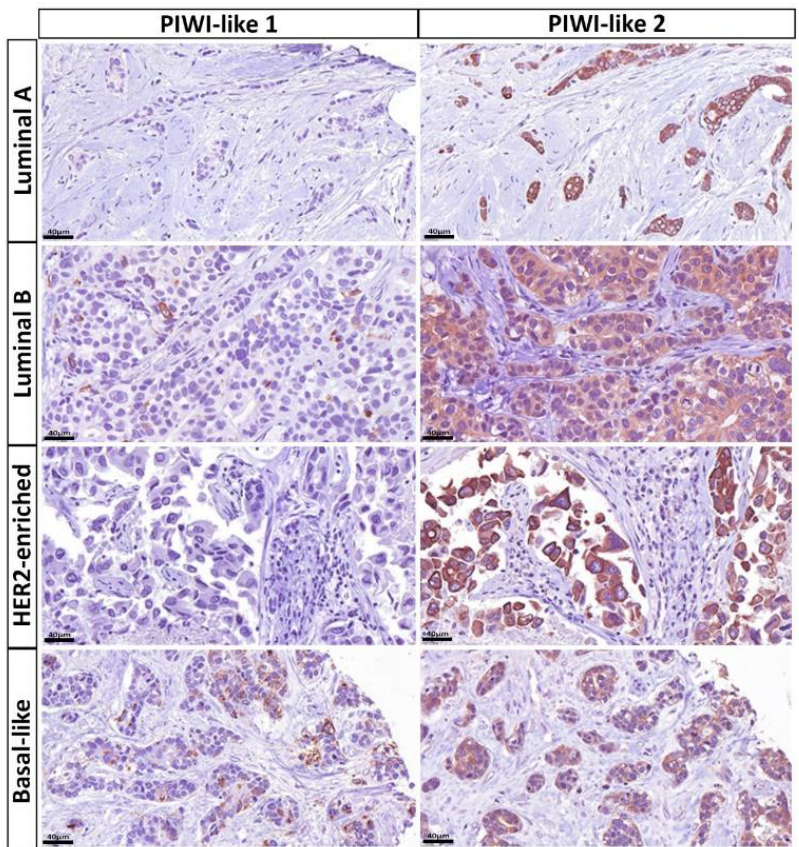
Figure 8. Immunohistochemical (IHC) expression patterns of PIWI-like 1 and PIWI-like 2 varied within the molecular PAM50 breast cancer subtypes: Luminal A breast cancer showed strong and homogenous PIWI-like 2 expression (IRS 12/12) in most cases, whereas there was no detection of PIWI-like 1 expression (IRS 0/12). In contrast, Luminal B and HER2-enriched tumors presented with either no or slight PIWI-like 1 expression (IRS 2/12 and 0/12, respectively). However, PIWI-like 2 staining was typically moderate to high (IRS 8/12 and 9/12, respectively). Basal-like breast cancer depicted increased PIWI-like 1 (IRS 4/12), but reduced PIWI-like 2 expression (IRS 6/12) when compared with Luminal A tumors. Tumors with low PIWI-like 2 IRS (<6) were about six times more often assigned to TNBC (27.3%) and approximately half as often to the Luminal A like subtype (24.5%) compared to patients with